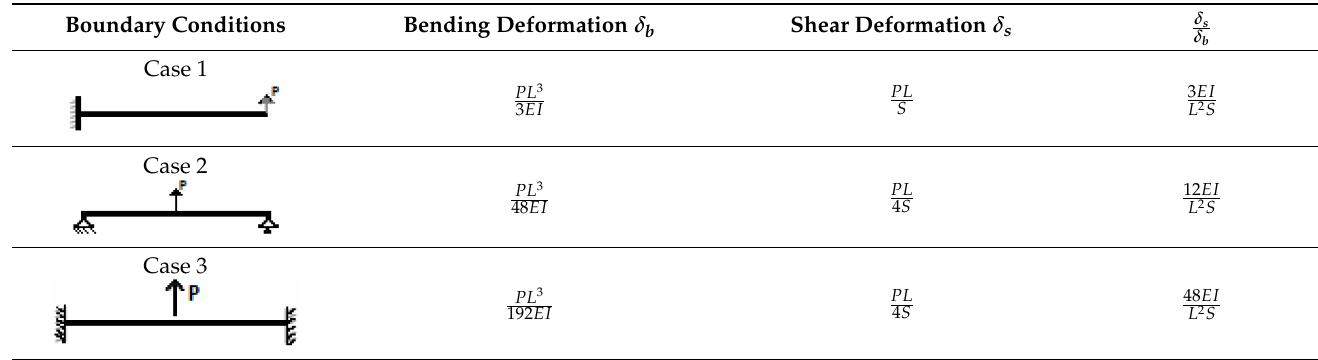
Table A3. Bending and shear deformation equations, formula adopted from